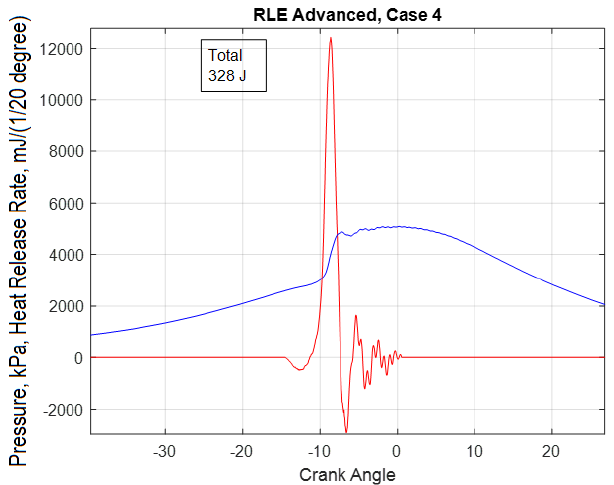
Figure 15. Instantaneous heat release rate for RLE Case 4.